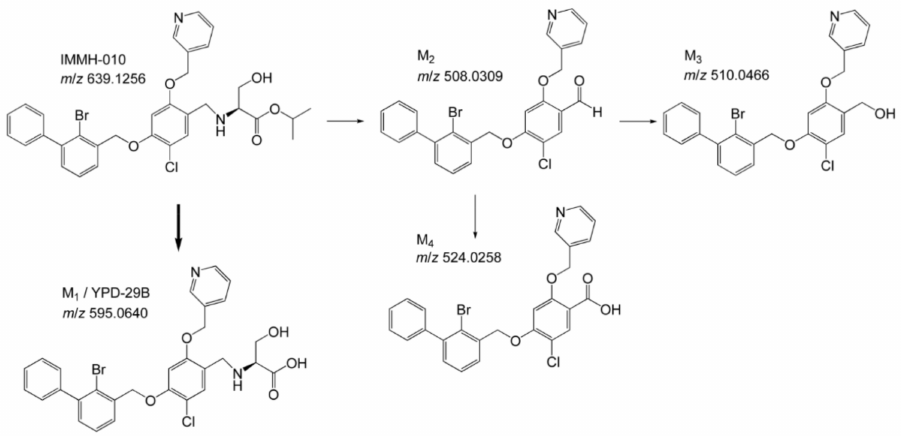
Figure 2. Metabolites of IMMH-010. The predominant metabolite is YPD-29B. M2, M3, and M4 are the IMMH-010 metabolites in which serine is removed, consistent with the synthesized refer- ence compounds.